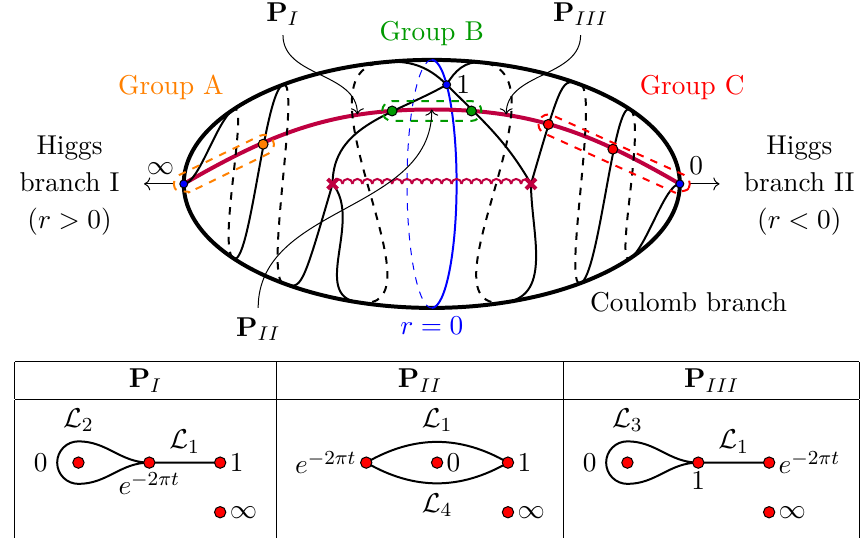
Figure 12 . Conifold Coulomb branch parameterized by z = e 2 πt